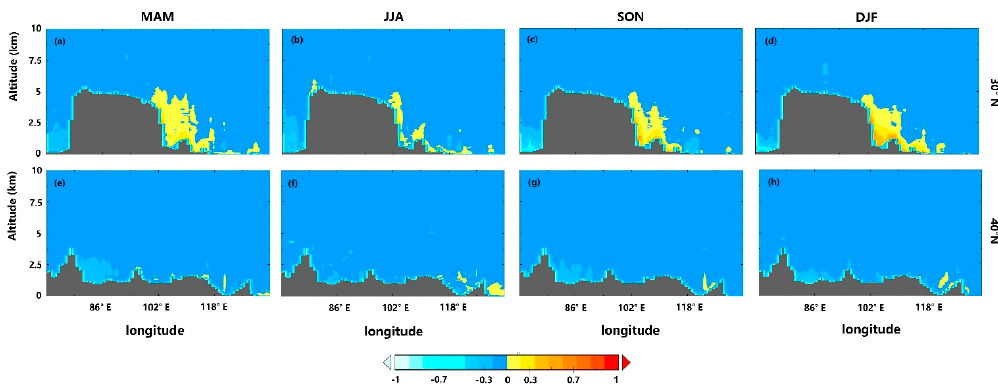
Figure 9. Cross sections of the seasonal differences of AEC values (unit: km − 1 ) along 30° N and 40° N of RAMS-CMAQ and CALIOP.